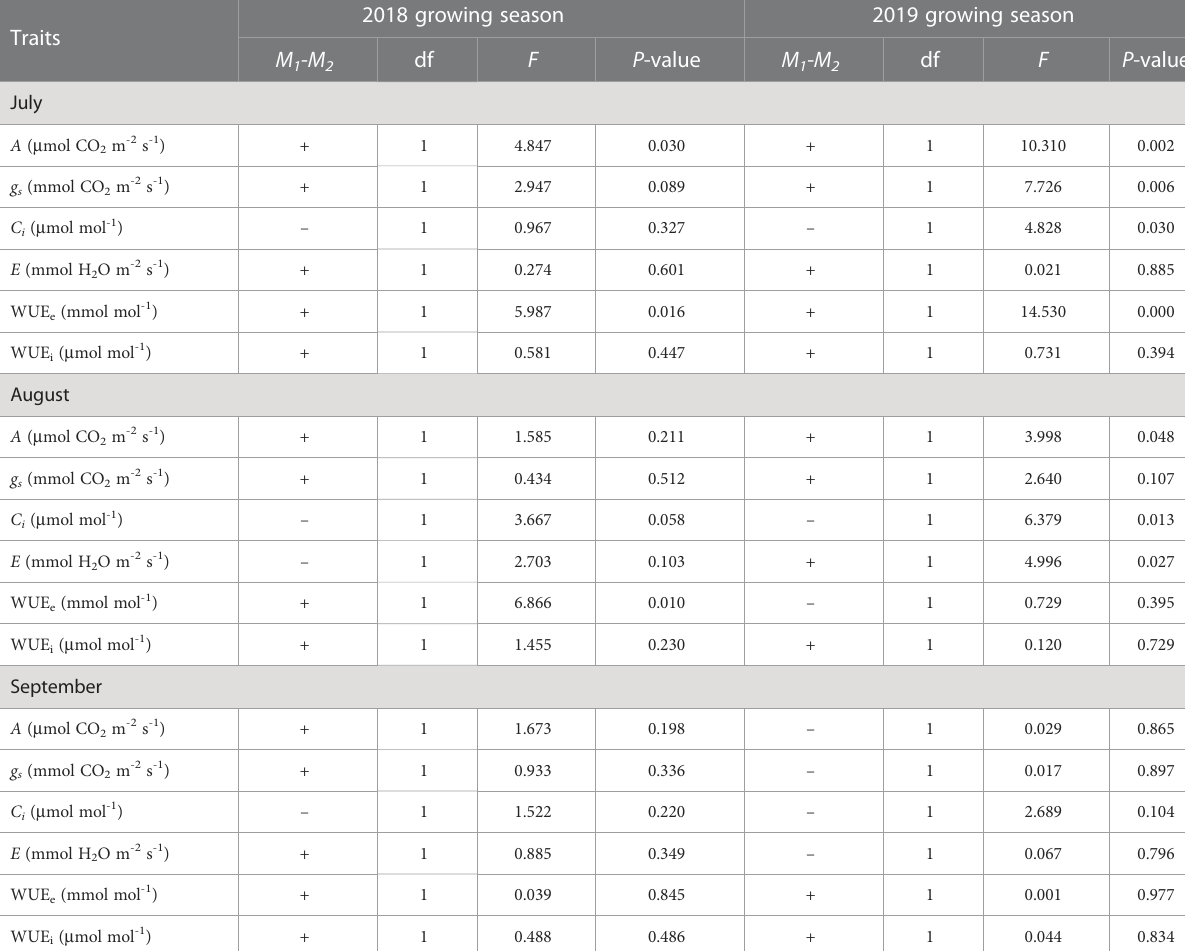
TABLE 2 One-way ANOVA on photosynthetic parameters of hybrid genotypes.